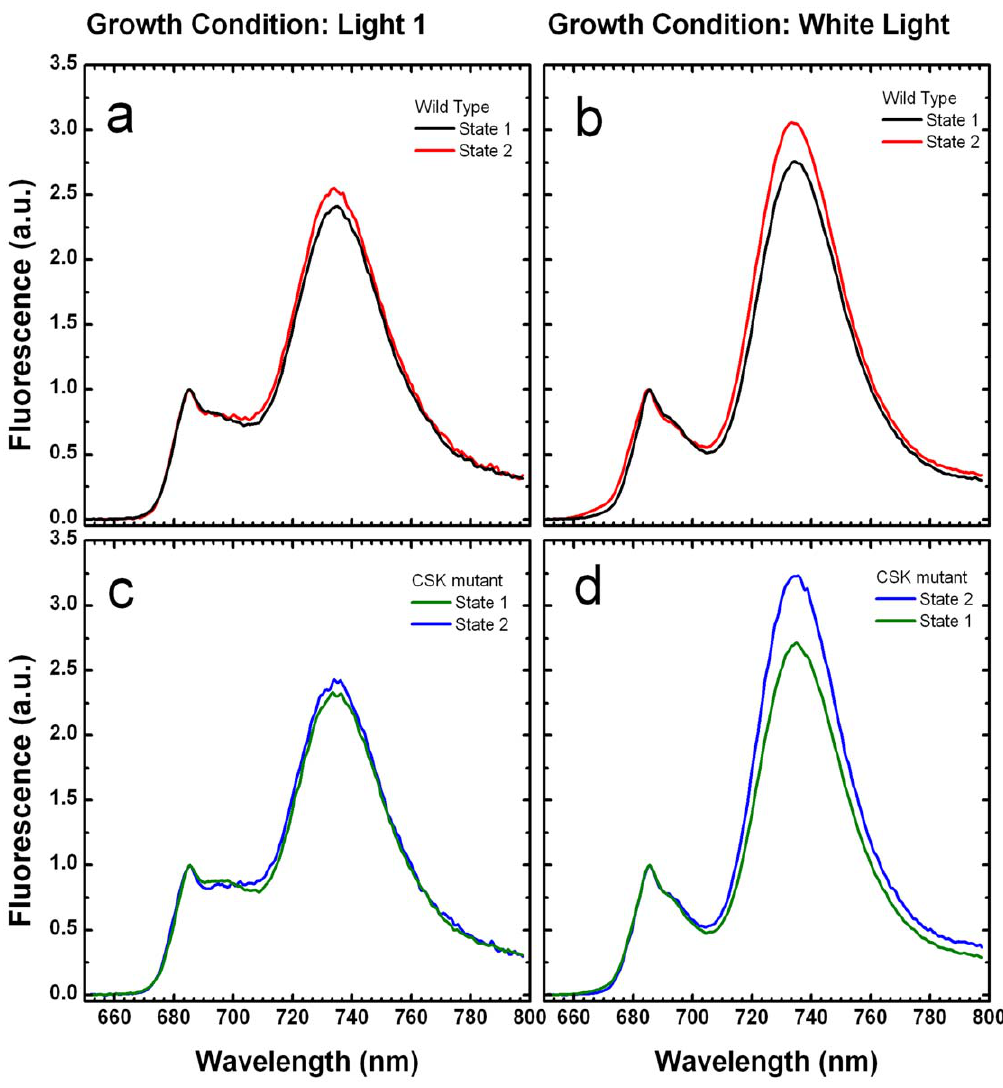
Figure 2. Fluorescence emission spectra of isolated thylakoids at 77 K. 77 K fluorescence emission spectra from wild type and CSK null mutant thylakoids as measured by the Perkin-Elmer LS 55 luminescence spectrometer. Figure 2a and 2c shows fluorescence emission spectra of thylakoids isolated from light 1 adapted plants. Figure 2b and 2d show fluorescence emission spectra of thylakoids isolated from white light grown plants. The excitation wavelength was 435 nm (5 nm slit width) and emission was detected from 650 to 800 nm (2.5 nm slit width). All spectra were normalized at 685 nm.